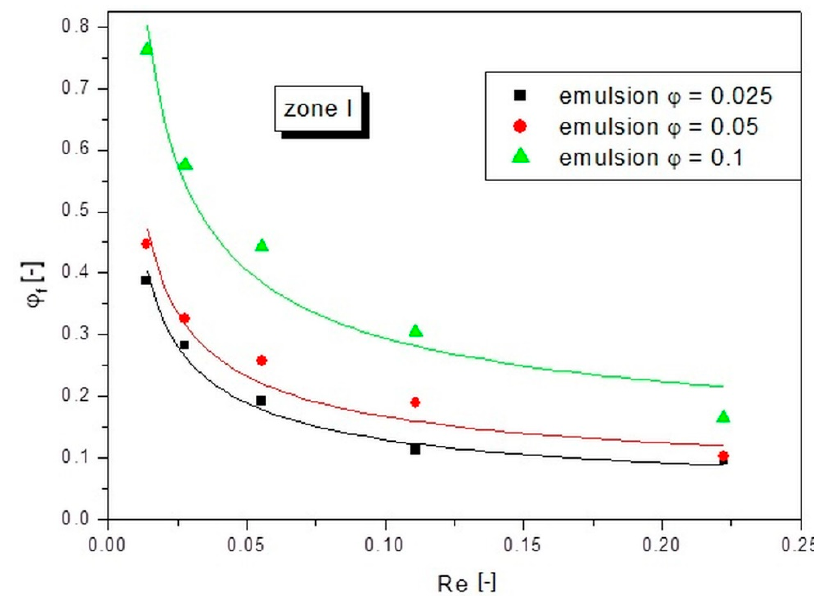
Figure 7. Dependences of the actual concentration on the Re number of the liquid for different emulsion concentrations in zone I.